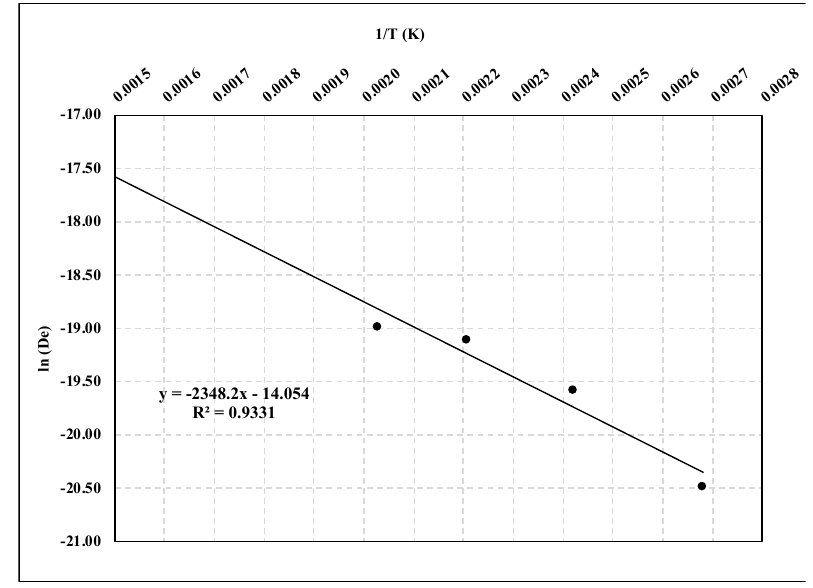
Figure 3. E ff ect of temperature on the pre-exponential factor in moisture di ff usivity during the Figure 3. Effect of temperature on the pre-exponential factor in moisture diffusivity during the roasting process. roasting process.